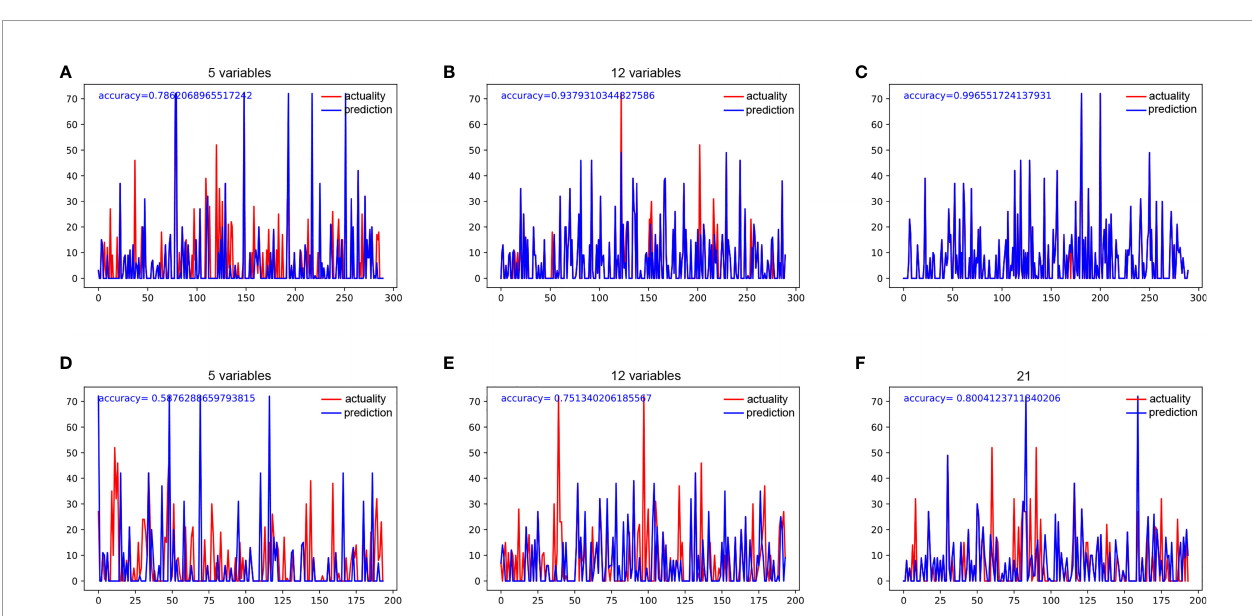
FIGURE 1 | Kaplan-Meier curves estimate of overall survival according to (A) Child-Pugh grade, (B) Maximum tumor size, (C) Resection margin, (D) Lymph node status, (E) Histological